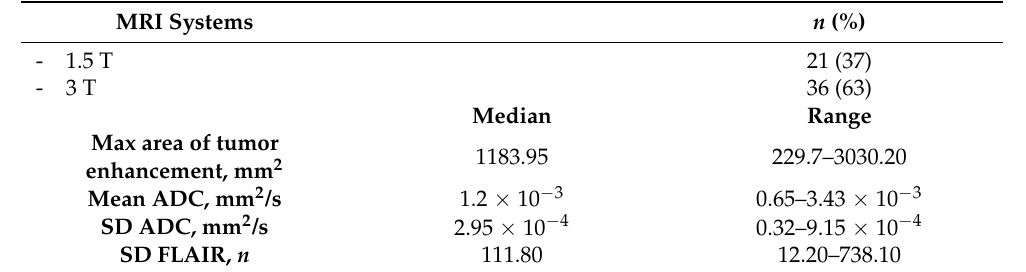
Table 2. MRI Texture